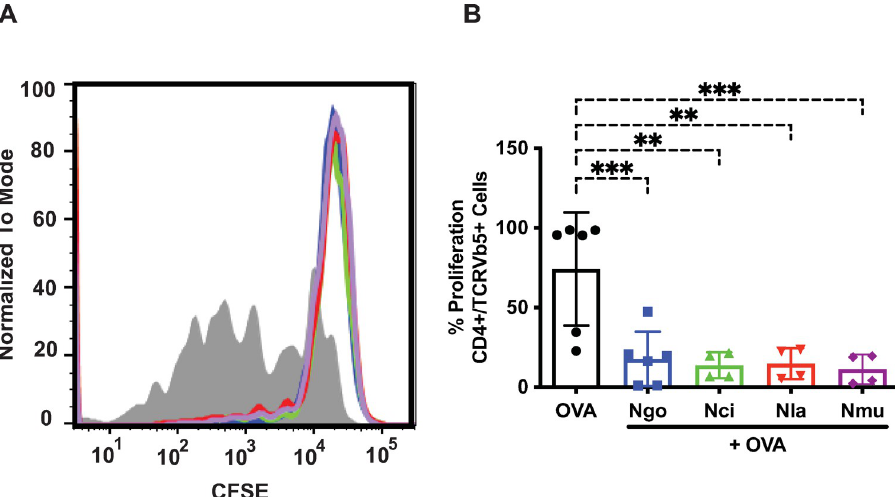
Fig 2. N . gonorrhoeae and three commensal Neisseria species inhibit OVA-primed dendritic cell-induced T cell proliferation. Dendritic cells (DCs) were exposed to N . gonorrhoeae ( Ngo ), N . cinerea ( Nci ), N . lactamica ( Nla) , or N . mucosa (Nmu) bacteria at an MOI = 10 in the presence of OVA for 24 hours. DCs were then washed and co-cultured with CFSE-loaded OT-II T cells for seven days. T cell proliferation stimulated by DC presentation of OVA